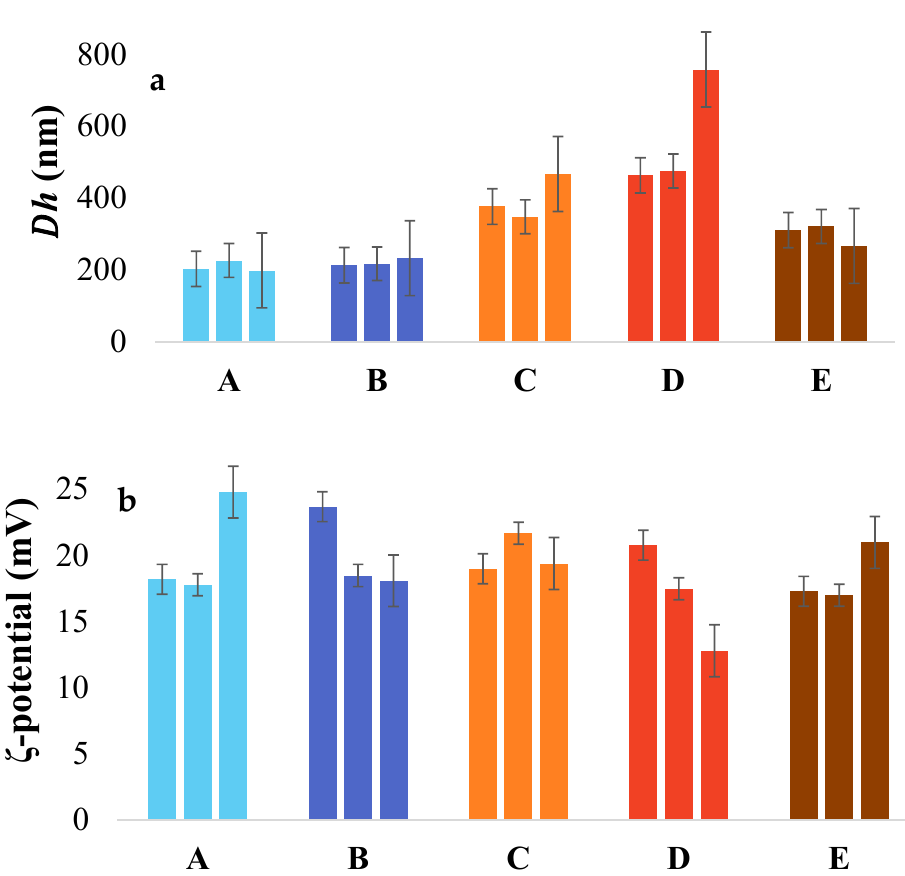
Figure 4. ( a ) Hydrodynamic diameter and ( b ) ζ-potential for commercial samples A and B from Sigma and Norland, respectively, and C, D, and E from different extraction protocols. For each sample we present three histograms correspond to measurements taken at days 0, 4, and 7 (from left to right).